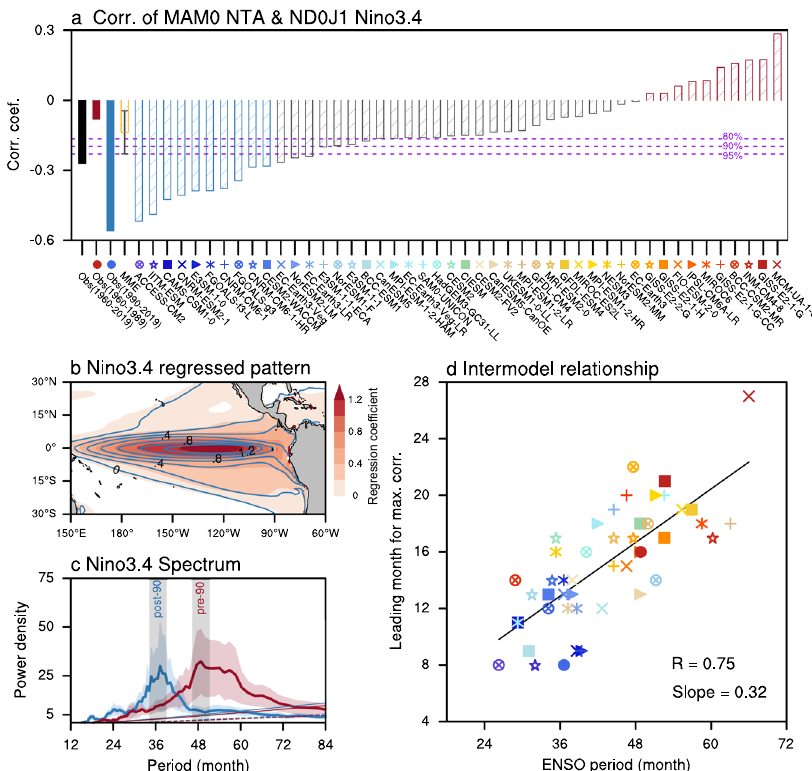
Fig. 2 Phase relationship of NTA SST anomalies with ENSO in pi-control climate simulations. a Lead correlation of boreal spring North Tropical Atlantic (NTA) sea surface temperature (SST) anomaly with the subsequent winter Niño3.4 index for 46 CMIP6 models and observations as a reference. The models are ranked by the NTA/ENSO correlation coef fi cients in an ascending order. The error bar for the multi-model ensemble (MME) mean corresponds to one standard deviation. The dashed purple lines represent the 80, 90, and 95% con fi dence levels. b Regression of SST anomalies (°C) upon the Niño3.4 index averaged for the left 10 models with most negative correlation (contours with interval: 0.4 °C; models indicated by striped blue bars in panel a and the right 10 models with most positive correlation (shading; models indicated by striped red bars in panel a ). c Multi-Taper-Method (MTM) power spectra averaged for the left 10 models with most negative correlation (solid thick blue) and the right 10 models with most positive correlation (solid thick red), superimposed by one standard deviation (blue and red shading). The observed spectral peaks of pre- and post-1990 periods (gray shading) are shown for comparison. The averaged AR(1) null hypothesis is displayed by a dashed thin line and the 95% con fi dence level is indicated by a solid thin line. d Scatterplot of ENSO period and lead-time for which negative correlation coef fi cients are maximized for boreal spring NTA SST anomaly with the subsequent Niño3.4 index. The linear fi t (solid black) is displayed together with the correlation coef fi cient R and